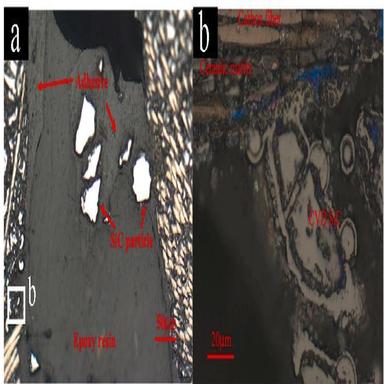
Cross-section of the punctured ceramic/needled ceramic bond-line.